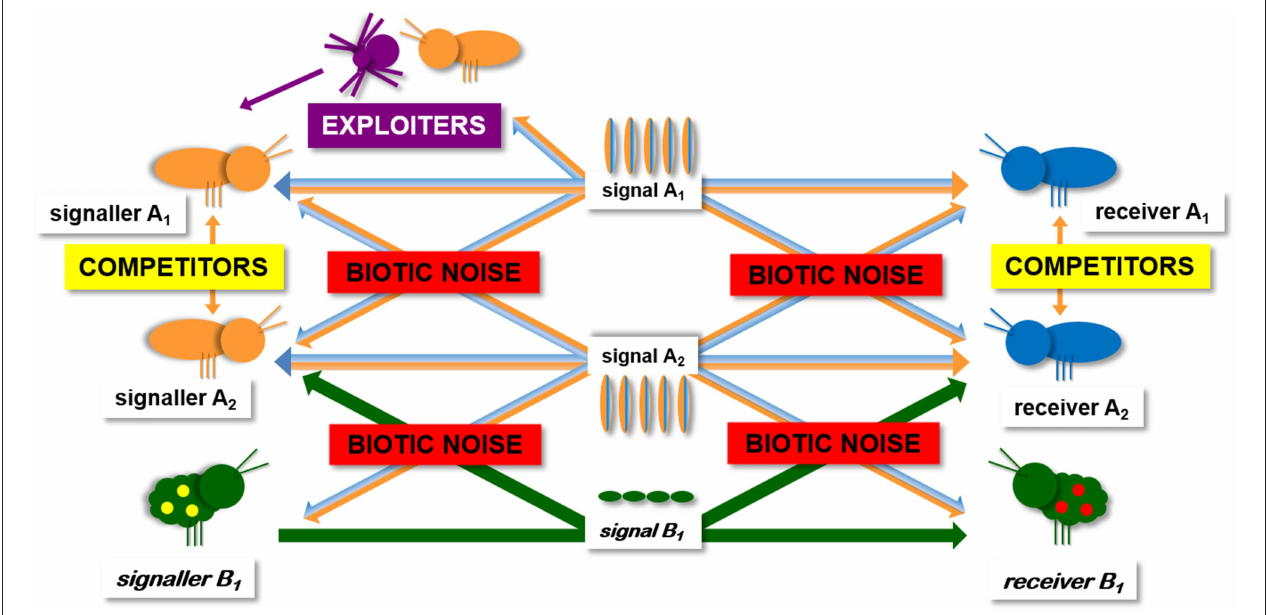
FIGURE 1 | Schematic presentation of insect vibrational communication network. Natural habitat contains other conspecific and heterospecific signallers, as well as eavesdropping exploiters like rivals and enemies. The complexity of any real world communication network depends on the identities and numbers of signallers and receivers able to detect the emitted signals. In a duetting communication system, the same individual is the emitter and the receiver (A1, A2). From potential interactions within such a communication network, it emerges that both, signallers and receivers take on a range of costs and benefits that may have fundamental implications for their communication